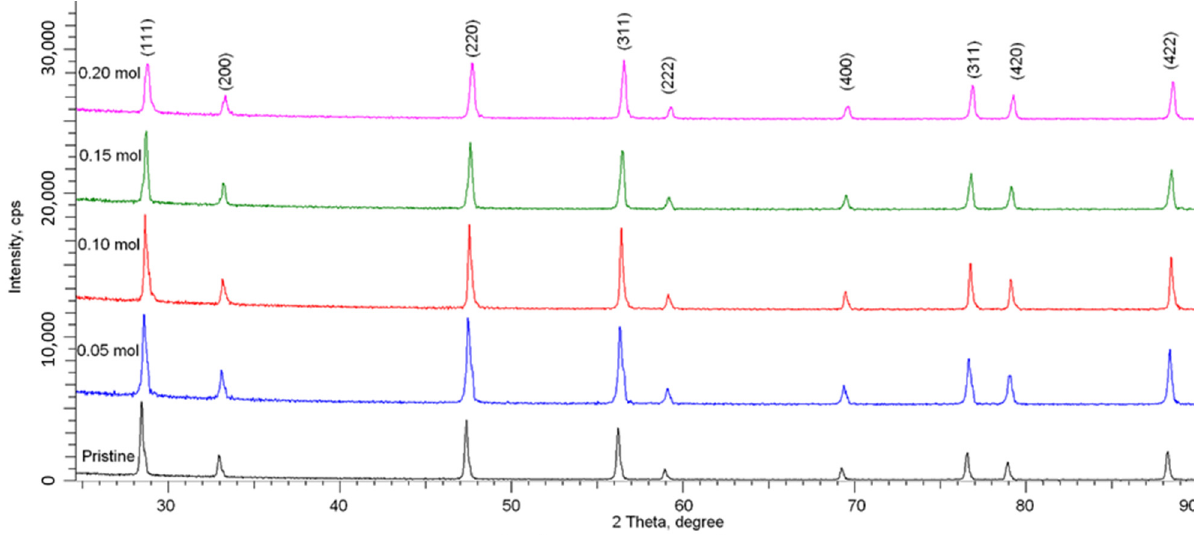
Figure 5. Results of X ‐ ray diffraction of the studied samples after irradiation.